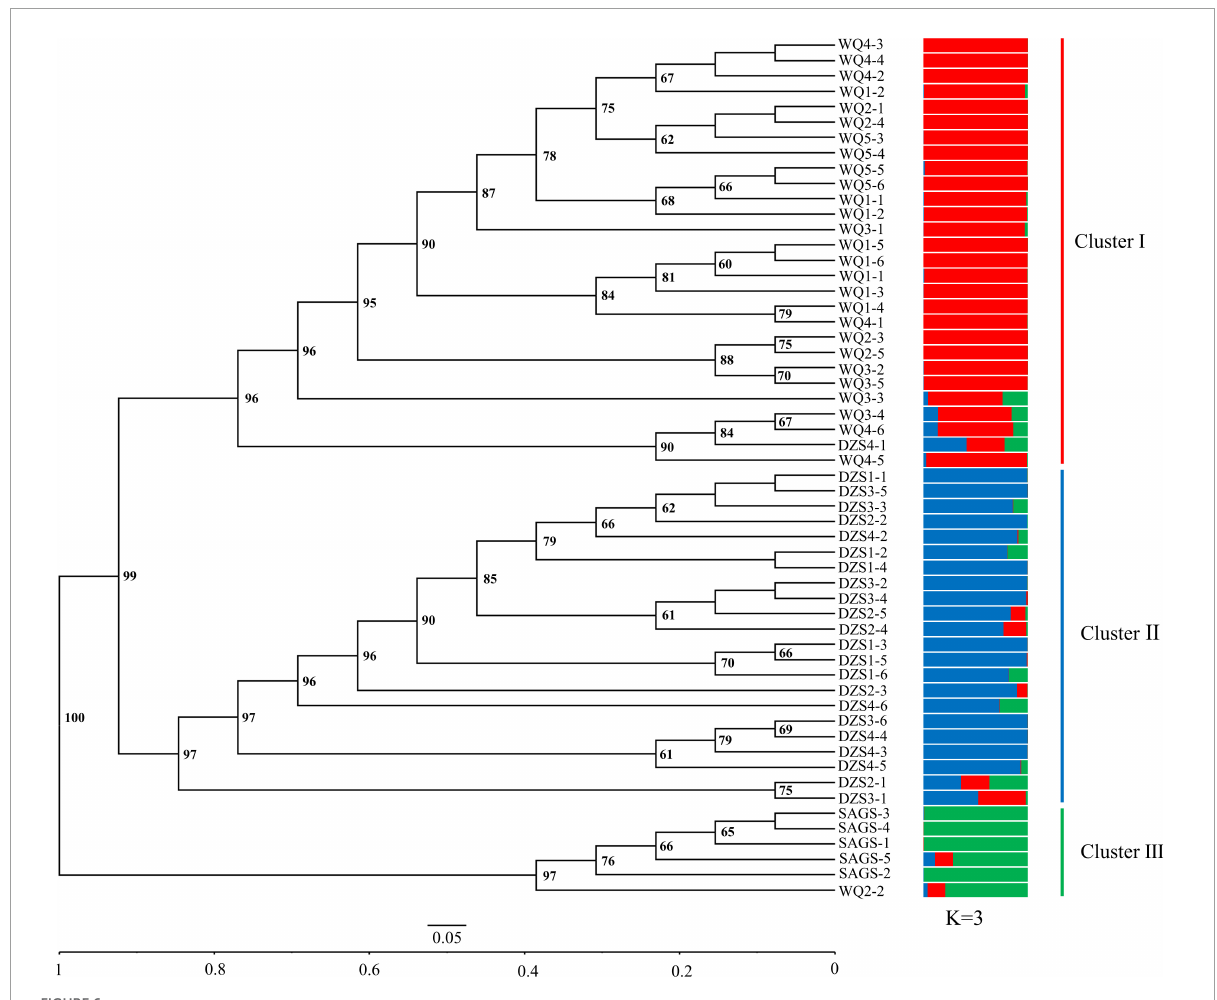
FIGURE6 The UPGMA dendrogram and genetic structure of 56 K. melanthera individuals based on 49 developed SSR markers. WQ, Waqie town; DZS, Dazhasi town; SAGS, Sichuan Academy of Grassland